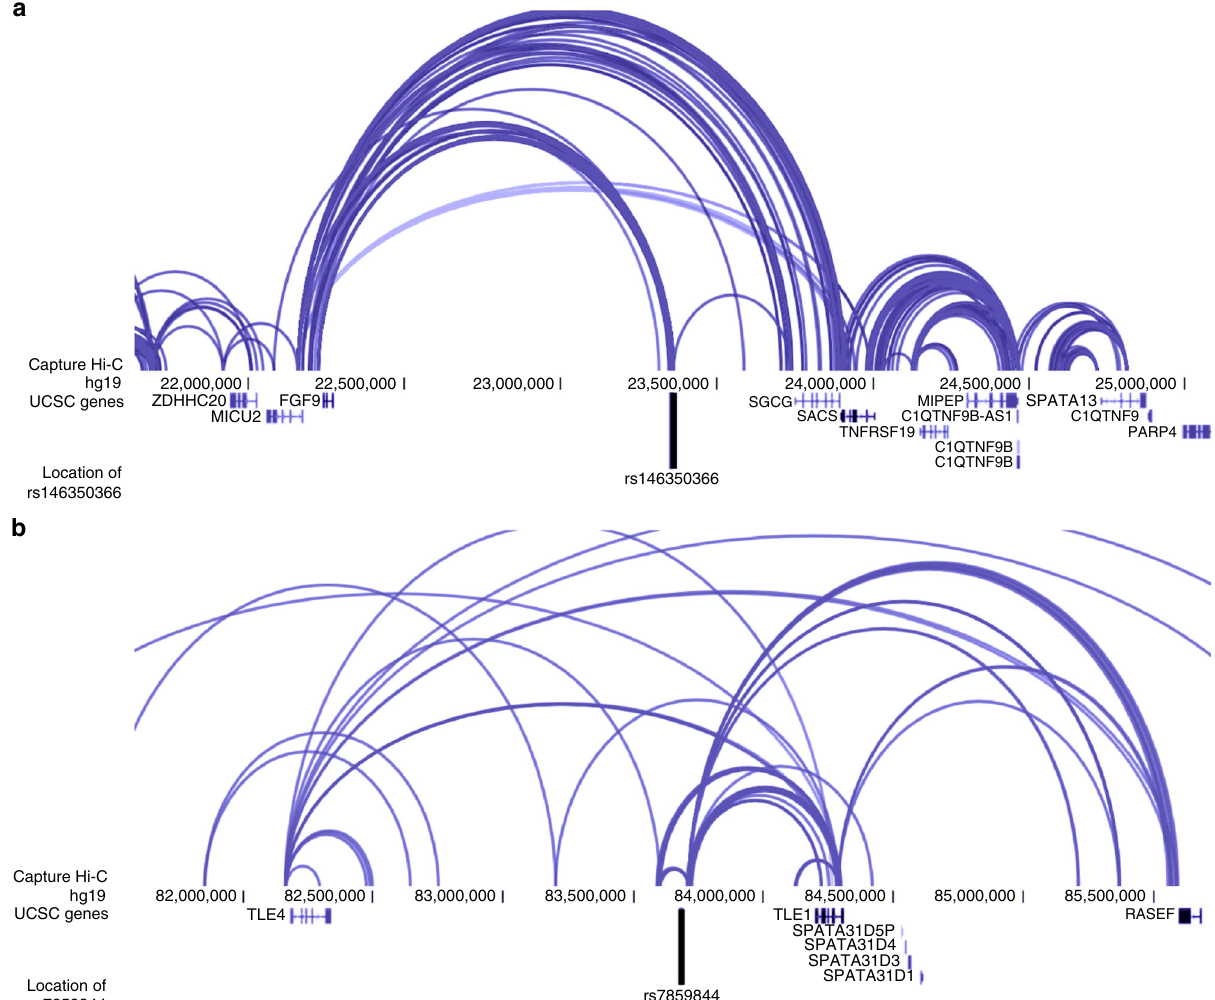
Fig. 4 Prioritizing genes using chromatin interaction data. a The GWAS association rs146350366 on chromosome 13 for sporadic miscarriage in the European ancestry meta-analysis shows functional connections to the FGF9/MICU9 region. The black vertical line represents the location of the signal from GWAS meta-analysis. b The GWAS association rs7859844 on chromosome 9 for multiple consecutive miscarriage meta-analysis shows functional connections to the TLE1 region. The black vertical line represents the location of the signal from GWAS meta-analysis. The 3D Genome Browser 42 was used for data visualization and the endothelial progenitors and fetal thymus data were selected to illustrate the chromatin architecture at loci in panels a and b , respectively. The visual representations do not infer/con fi rm possible target tissues for the